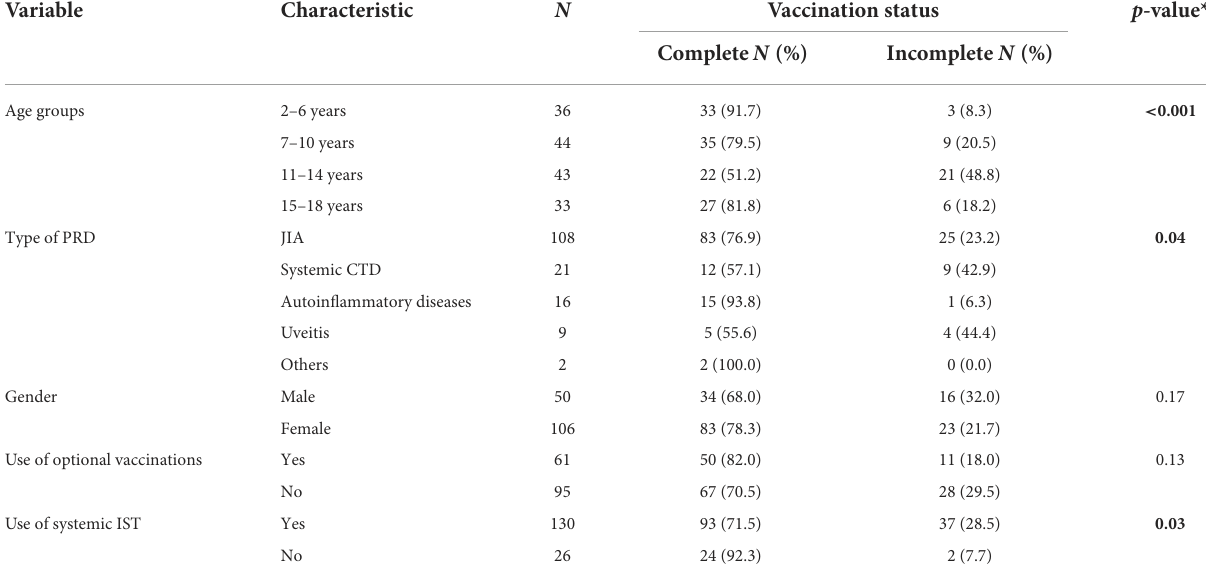
TABLE 2 Associations of selected variables with vaccination status. Variable